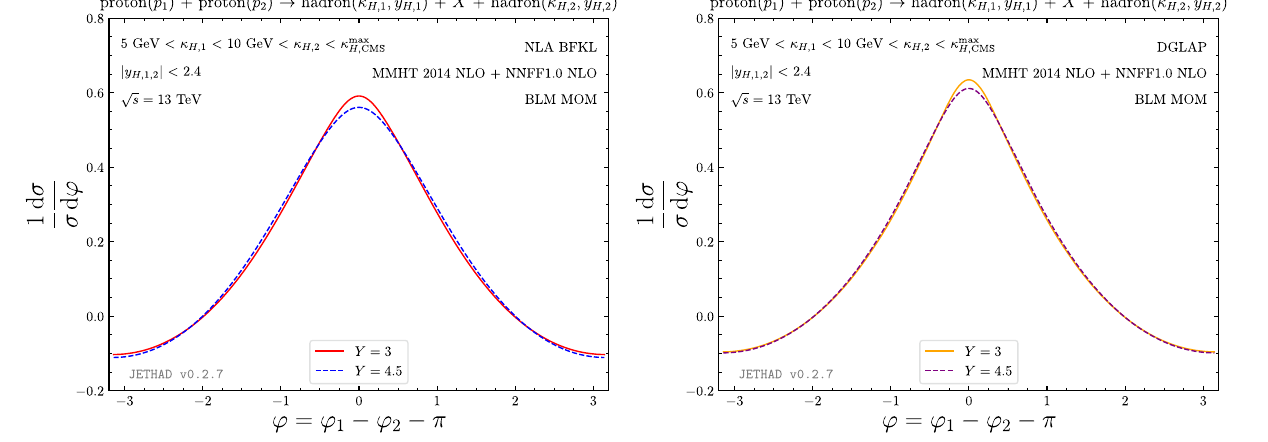
Fig. 18 NLA BFKL (left) and high-energy DGLAP (right) predic- tionsfortheazimuthaldistributionoftheinclusivedi-hadronproduction (right panel of Fig. 2), for two distinct values of the final-state rapidity